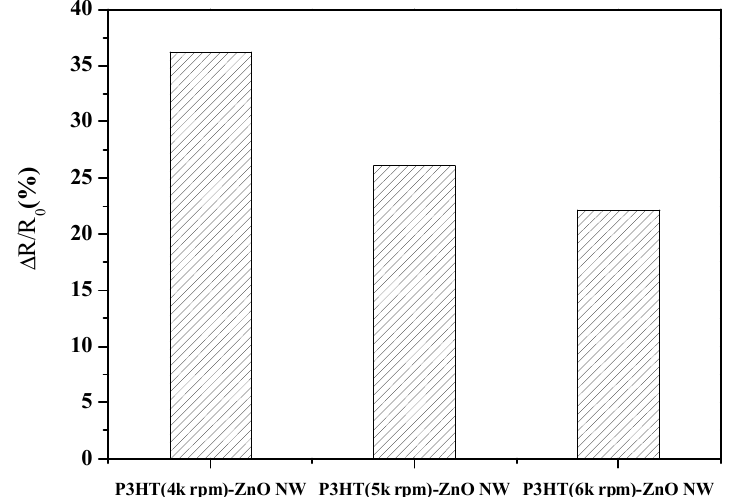
Figure 7. The responses of the poly(3-hexylthio-phene) (P3HT)-ZnO nanowires sensors with various thicknesses of the P3HT detecting 5 ppm ammonia gas.